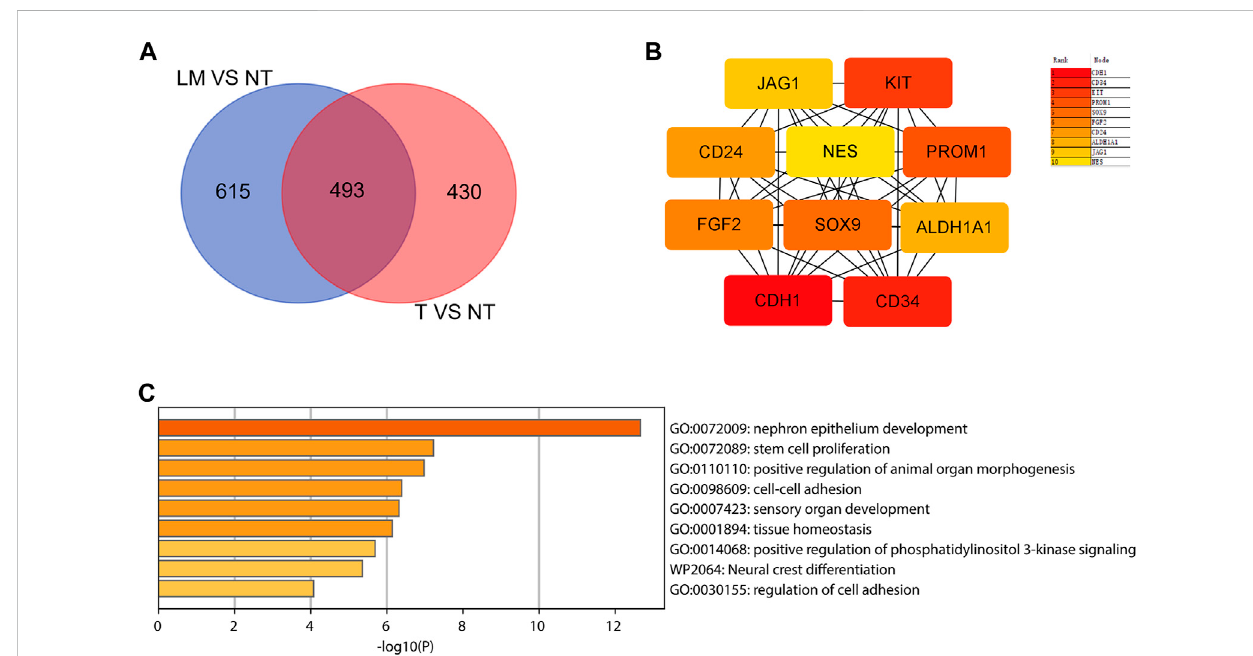
FIGURE 7 Hubgenesselectionandanalysis. (A) Venndiagramshowsthe493overlappingDEGs. (B) Thetop10hubgenesinthePPInetworkwerescreenedby CytoscapeplugincytoHubba.The10identi fi edhubgenessuchasCDH1,CD34,KIT,PROM1,SOX9,FGF2,CD24,ALDH1A1,JAG1,NESaredisplayedfrom red (high degree value) to yellow (low degree value). (C) GO and KEGG pathway enrichment analysis of the 10 hub